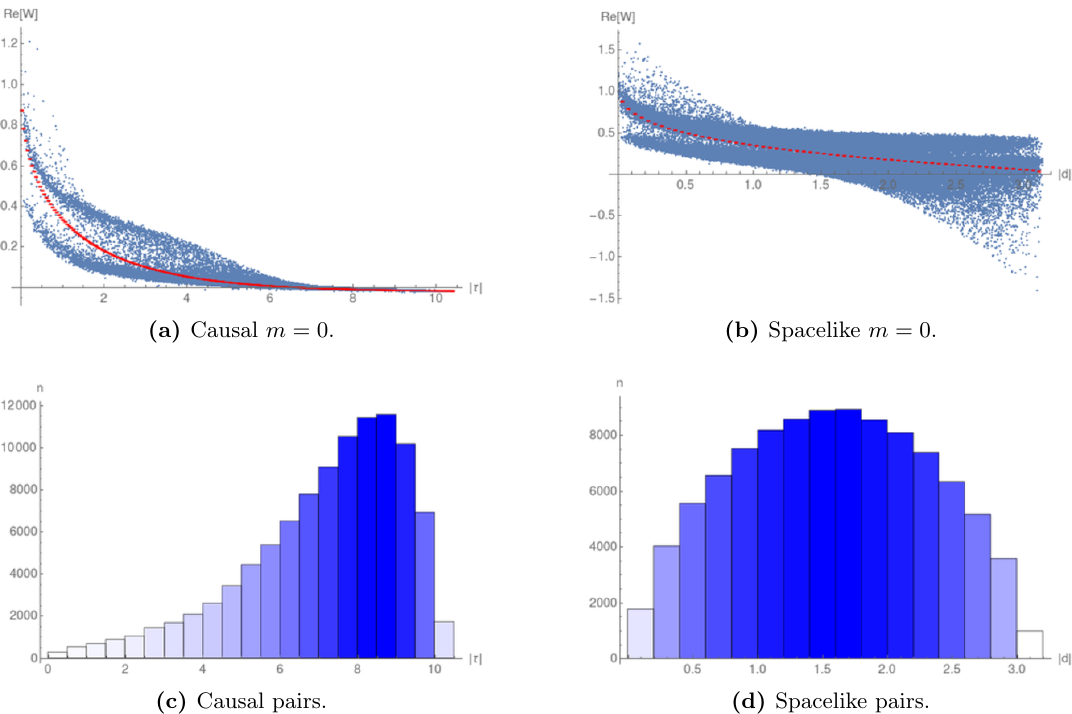
(c) Causal pairs. (d) Spacelike pairs. Figure 15. N = 36000 ; (cid:0) 1 : 56 < ~ T < 1 : 56 ; (cid:26) = 30 : 93, in 2d de Sitter. (a)-(b) represent Re[ W vs. geodesic distance for a sample of 100000 randomly selected pairs. The red curve represents the mean values (of the data) with the SEM. (c)-(d) are plots of the distribution of pairs.